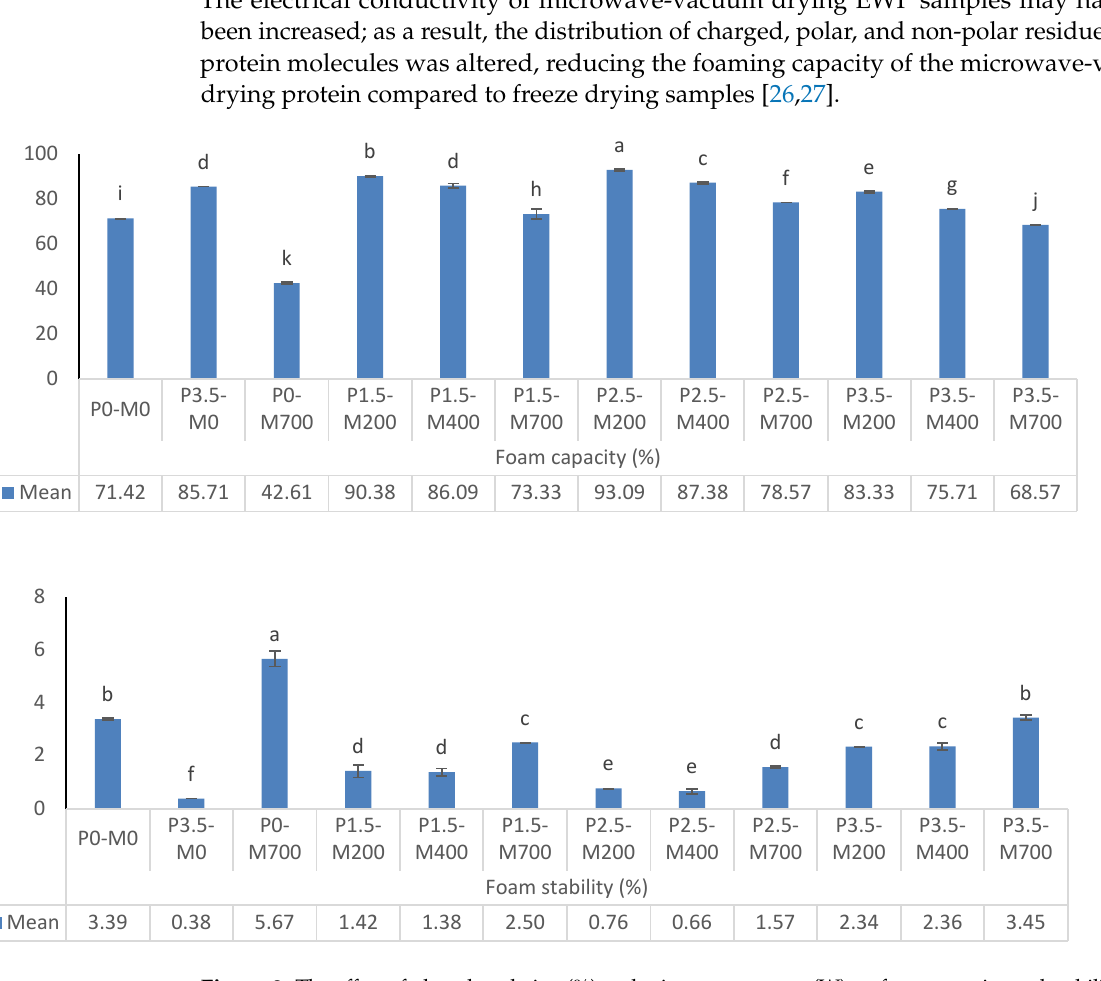
Figure 2. The effect of phosphorylation (%) and microwave power (W) on foam capacity and stability of egg white powder. Means ( n = 3) with different letters in each column indicate significant difference ( p < 0.05).